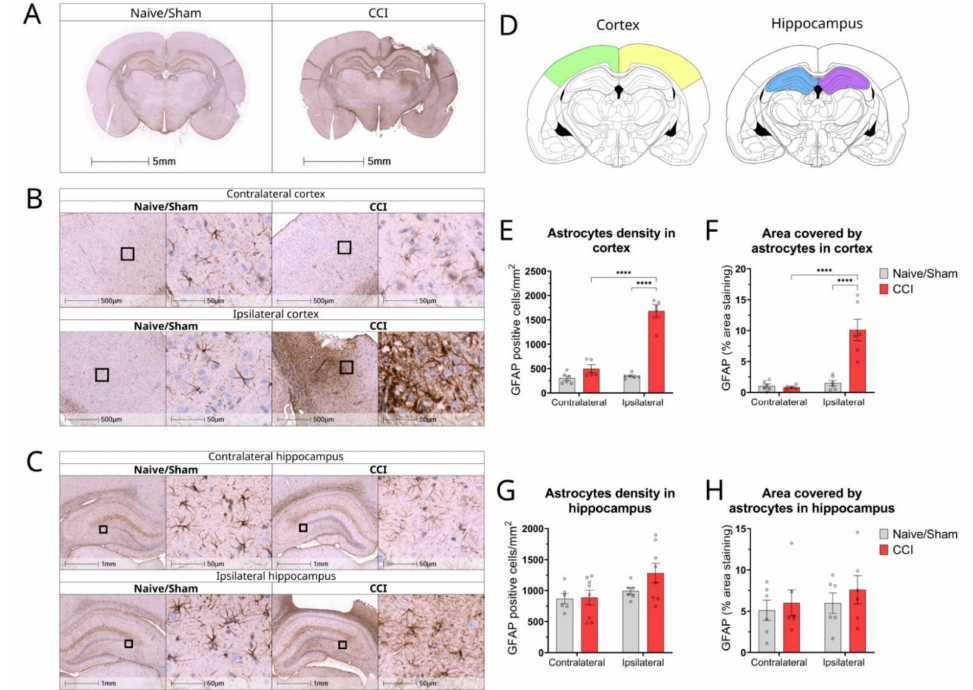
Figure 4. Changes in astrocyte density, morphology and distribution in cortex and hippocampus of CCI rat brains 2 weeks post-injury. ( A ) Representative whole brain photomicrographs of GFAP+ staining in naïve/control and CCI rat brains; ( B ) Magnified representative images of GFAP staining in cortex of naïve/sham animals and CCI brains from ipsilateral and contralateral sides of the injury; ( C ) Magnified representative images of GFAP staining in the hippocampus of naïve/sham animals and CCI brains from ipsilateral and contralateral sides of the injury; ( D ) Brain atlas images, showing areas of cortex and hippocampus analysed; ( E ) Quantification of the GFAP+ cell count/ mm 2 in the cortex of CCI and sham/naïve control rats (2-way ANOVA hemisphere F(1,18) = 67.93 p < 0.0001, injury F(1,18) = 104.8 p < 0.0001, interaction F(1,18) = 58.42 p < 0.0001); ( F ) Quantification of GFAP percentage area covered in the cortex of CCI and sham/naïve control rats (-2way ANOVA hemisphere F(1,19) = 25.57 p < 0.0001, injury F(1,19) = 18.95 p = 0.0003, interaction F(1,19) = 20.88 p = 0.0002); ( G ) Quantification of the GFAP+ astrocytes count/mm 2 in the hippocampus of CCI and sham/naïve control rat (2-way ANOVA hemisphere F(1,24) = 4.515 p = 0.0441, injury F(1,24) = 1.590 p = 0.2194, interaction F(1,24) = 1.259 p = 0.2730); ( H ) Quantification of GFAP percentage area covered in the hippocampus of CCI and sham/naïve control rats (2-way ANOVA hemisphere F(1,20) = 0.719 p = 0.4063, injury F(1,20) = 0.736 p = 0.4009, interaction F(1,20) = 0.061 p = 0.8071). All data are presented as mean ± SEM, n = 5–8 per group. Two-way ANOVA, **** p < 0.0001. Mouse brain atlas images were obtained from the Allen Institute website (www.alleninstitute.org, accessed on 29 September